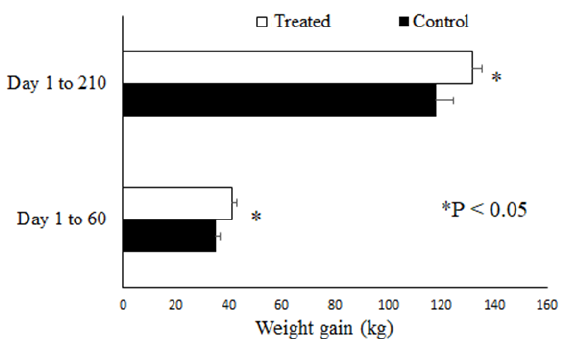
Figure 1 - Weight gain of calves treated with a mixture containing components of essential oils. * P<0.05 indicates significant difference between